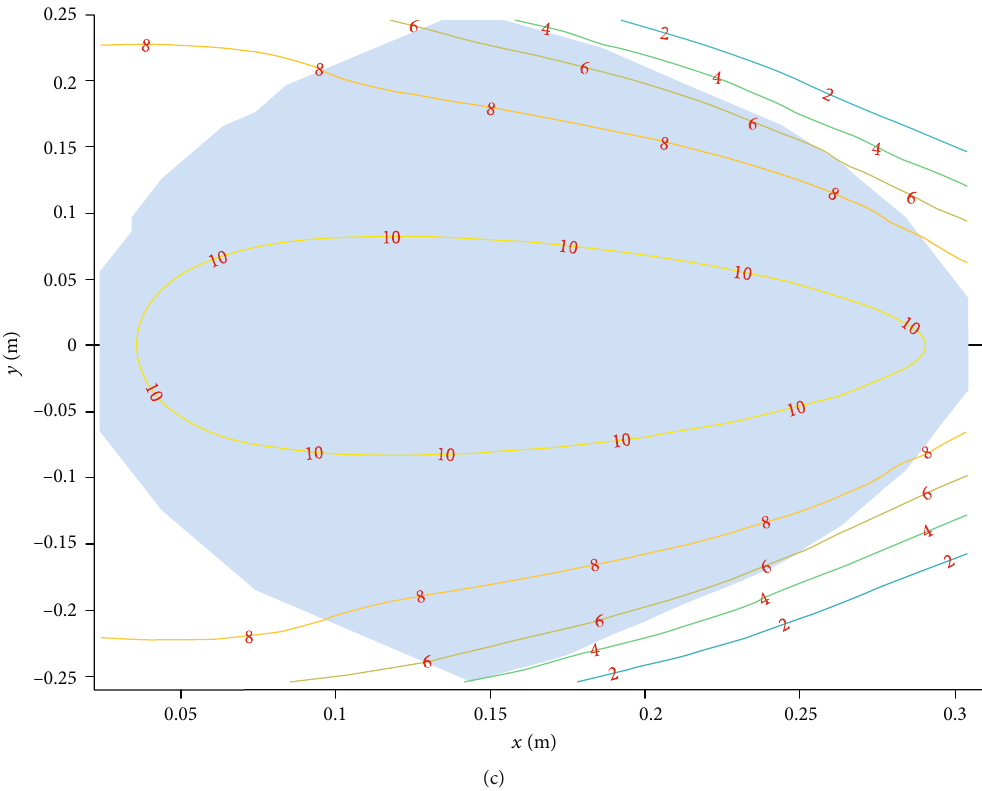
Figure 6: The condition number in di ff erent con fi tral area, the sti ff ness is maximum, which is about 4 : 5 × 10 5 N/m , while its sti ff ness is declining rapidly when the end e ff ector is near the boundaries of the workspace. And the sti ff ness is declining more rapidly along the positive direction than the negative direction of x ‐ axis . When a = 0 : 25 m , which means a is the minimum, the sti ff ness of the manipulator is shown in Figure 5(b). The distribution of sti ff ness is similar to Figure 5(a), but the central area is moving with negative x ‐ axis , and the whole sti ff ness mapping fi gure moves about 0.05m along the negative x ‐ axis . The sti ff ness mapping along the y ‐ axis is as symmetrical as when a = b . The sti ff ness of the manipulator is shown in Figure 5(c), when a = 0 : 475 m . Same as the above, near the central area, the manipulator has the highest sti ff ness and near the boundaries, the sti ff ness of the manipulator is declining. The acceptable sti ff ness range along the x ‐ axis decreases, as well. However, the range along the y ‐ axis becomes larger than a = b and a = 0 : 25 m . And the shape of the mapping is the same as the mechanism ’ s structure in this con fi guration. According to these fi gures,